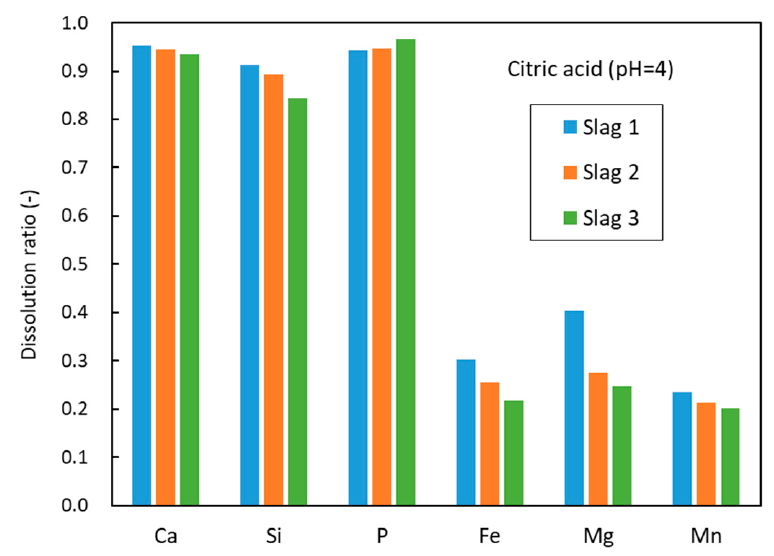
Figure 5. Dissolution ratio of each element from dephosphorization slag in citric acid solution at pH 4.